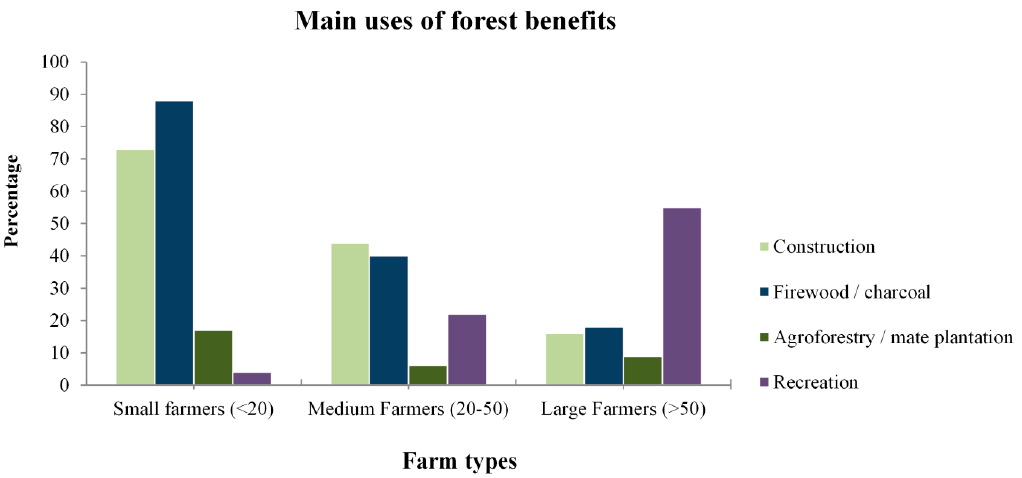
Figure 8. Main uses of forest related products based on farm type.